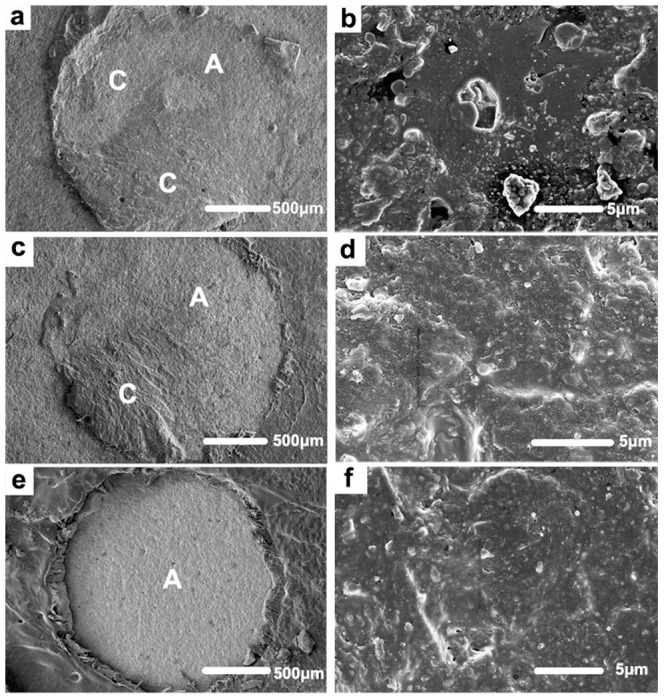
Scanning electron microscopy images of representative failure modes in the CCP and ZPP subgroups.(a, b) low and high magnification images of a mixed failure mode in the CCP-0.3 subgroup after thermocycling, with a large percentage of cohesive failure at the bonding interface and small area of primer remnant on the zirconia surface; (c, d) low and high magnification images of a mixed failure mode in the ZPP-0.1 subgroup without thermocycling, with a small percentage of cohesive failure mode; (e, f) low and high magnification images of complete adhesive failure in CCP-0.1 subgroup after thermocycling, with primer residues on the zirconia surface. (a, c, e) 50× magnification; (b, d, f) 5,000× magnification. A: adhesive failure from zirconia surface; C: cohesive failure in SA Luting resin cement.